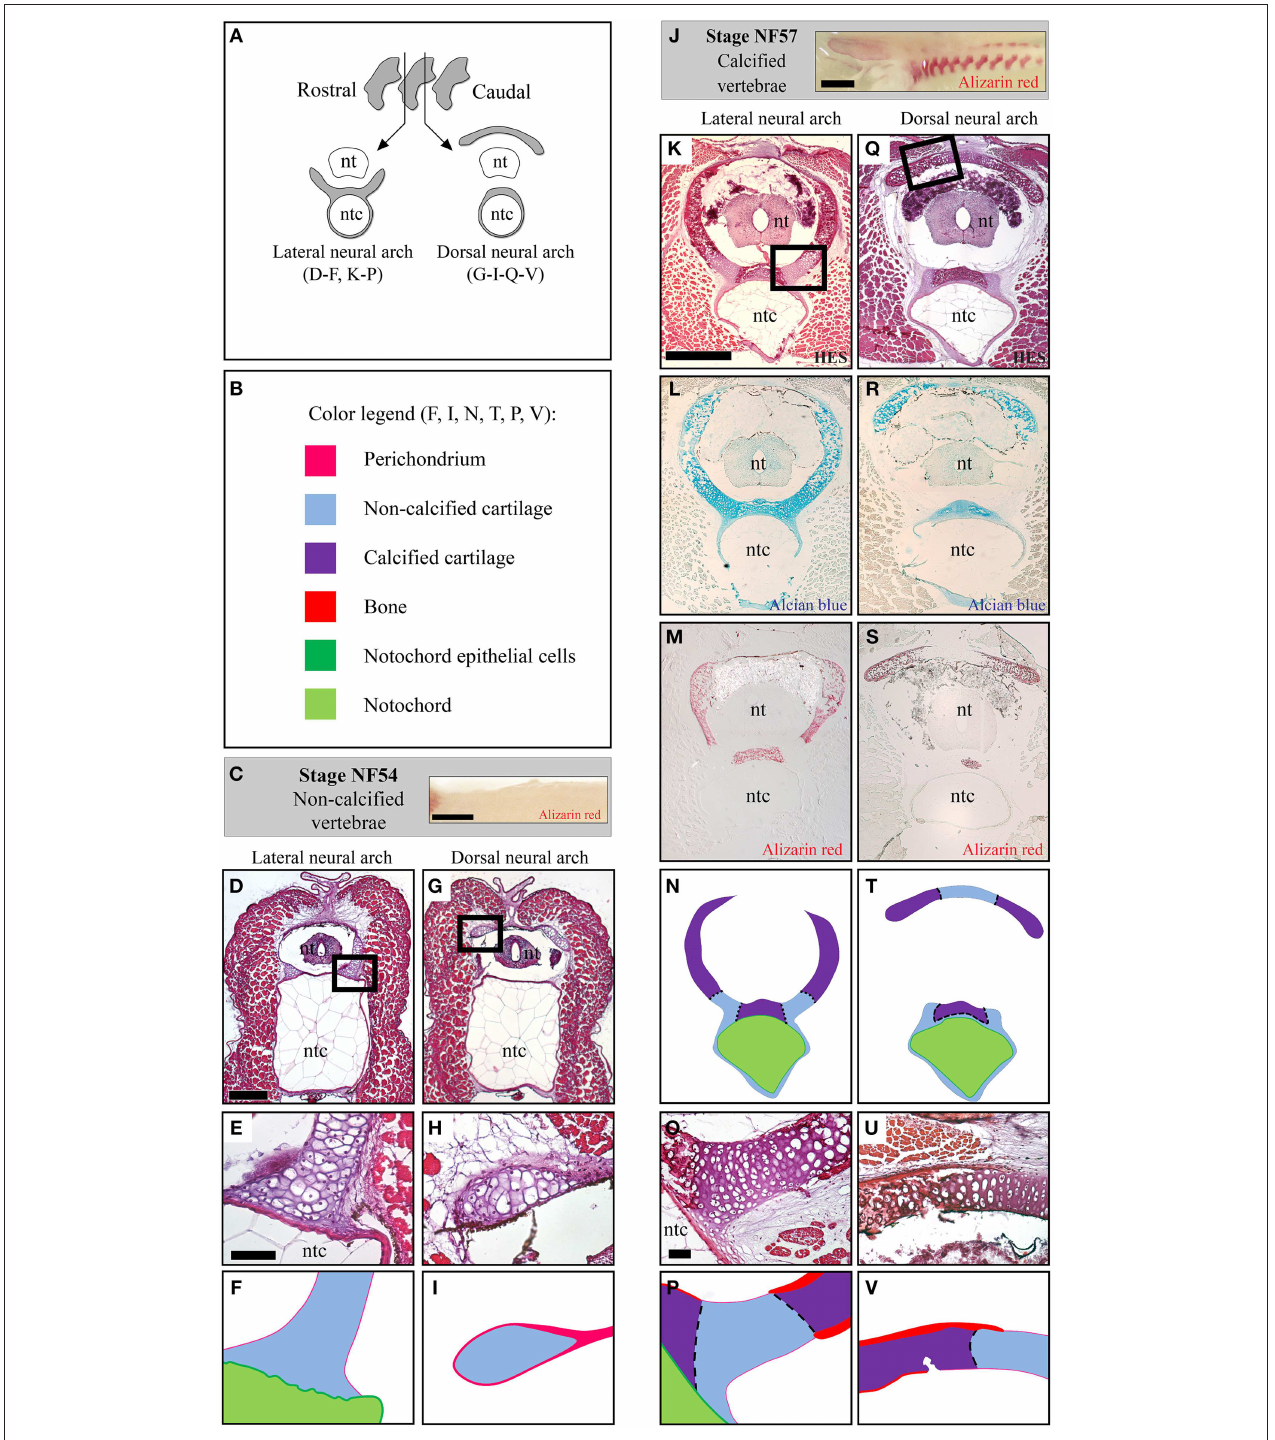
FIGURE 4 | Histology of the developing Xenopus tropicalis vertebrae. (A) Schematic drawing of transverse sections running through the lateral or the dorsal region of the neural arches. (B) Color code used to represent the distinct skeletal tissues of the X.t. vertebrae in (F,I,N,T,P,V) . (C) Whole mount Alizarin red staining of stage NF54 vertebral column (lateral view, anterior to the left). (D–I) Histology of the stage NF54 vertebrae examined with HES (D,E,G,H) . (J) Whole mount Alizarin red staining of stage NF57 vertebral columns (lateral view, anterior to the left). (K–V) Histology of the stage NF57 vertebrae examined with HES (K,O,Q,U) , Alcian blue (L,R) and Alizarin red (M,S) . Insets in D, G, K and Q are shown in F, I, P and V , respectively. Panels E, H, K, O, Q and U are schematized in F, I, N, P, T and V , respectively. Abbreviations: nt, neural tube; ntc, notochord. Scale bars: 1mm in (C,J) ; 250 µ m in (D,G) ; 50 µ m in (E,F) and (H,I) ; 500 µ m in (K–N) and (Q–T) ; and 50 µ m in (O,P,U,V)